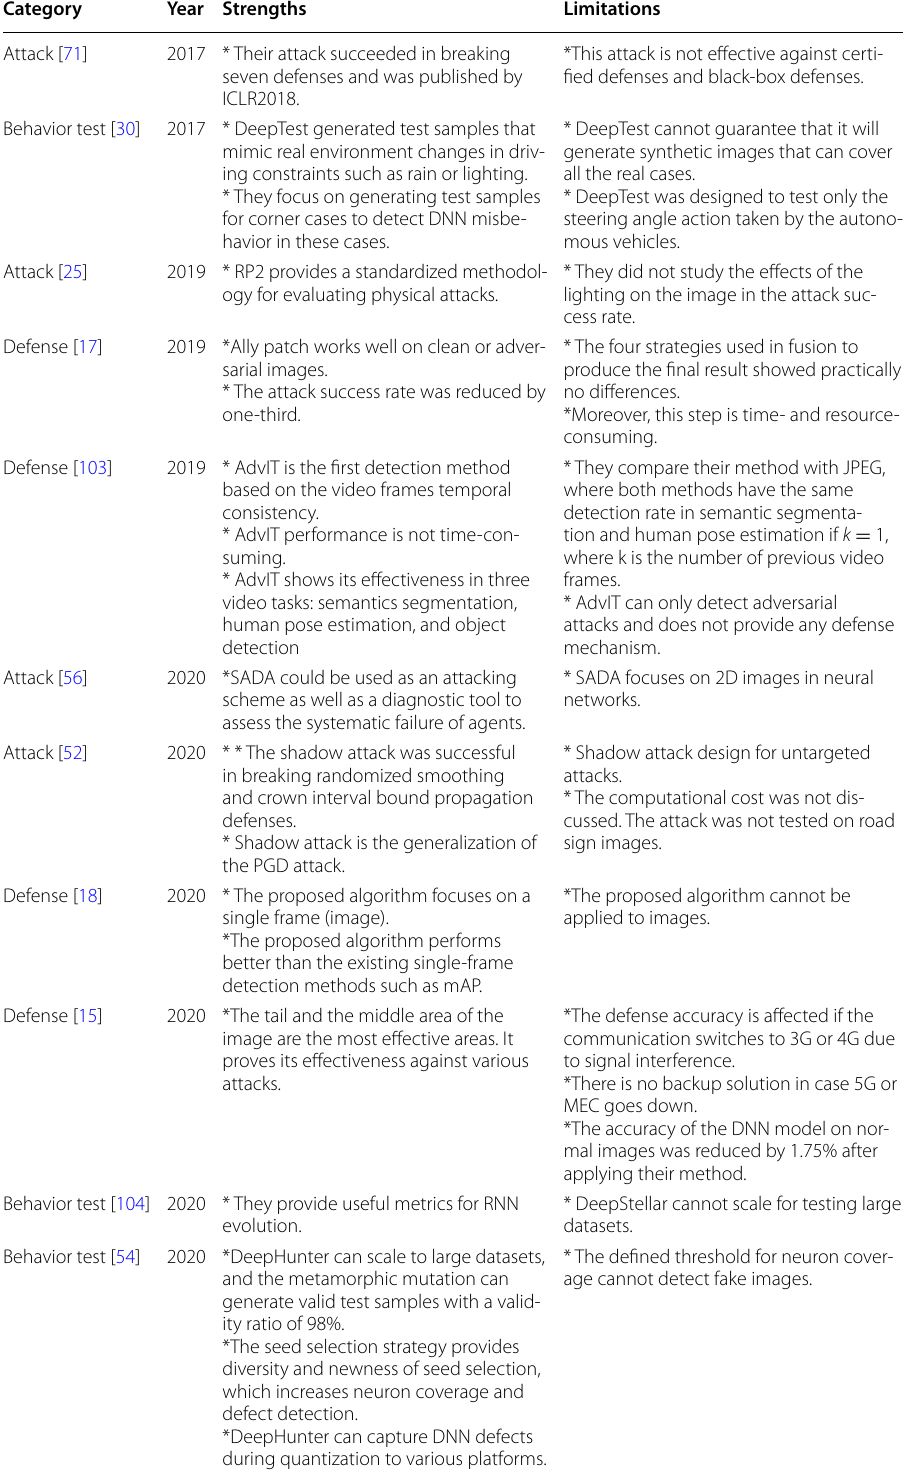
Table 3 Comparison of the existing models of adversarial attacks, defenses, and test frameworks Category Year Strengths Limitations Attack